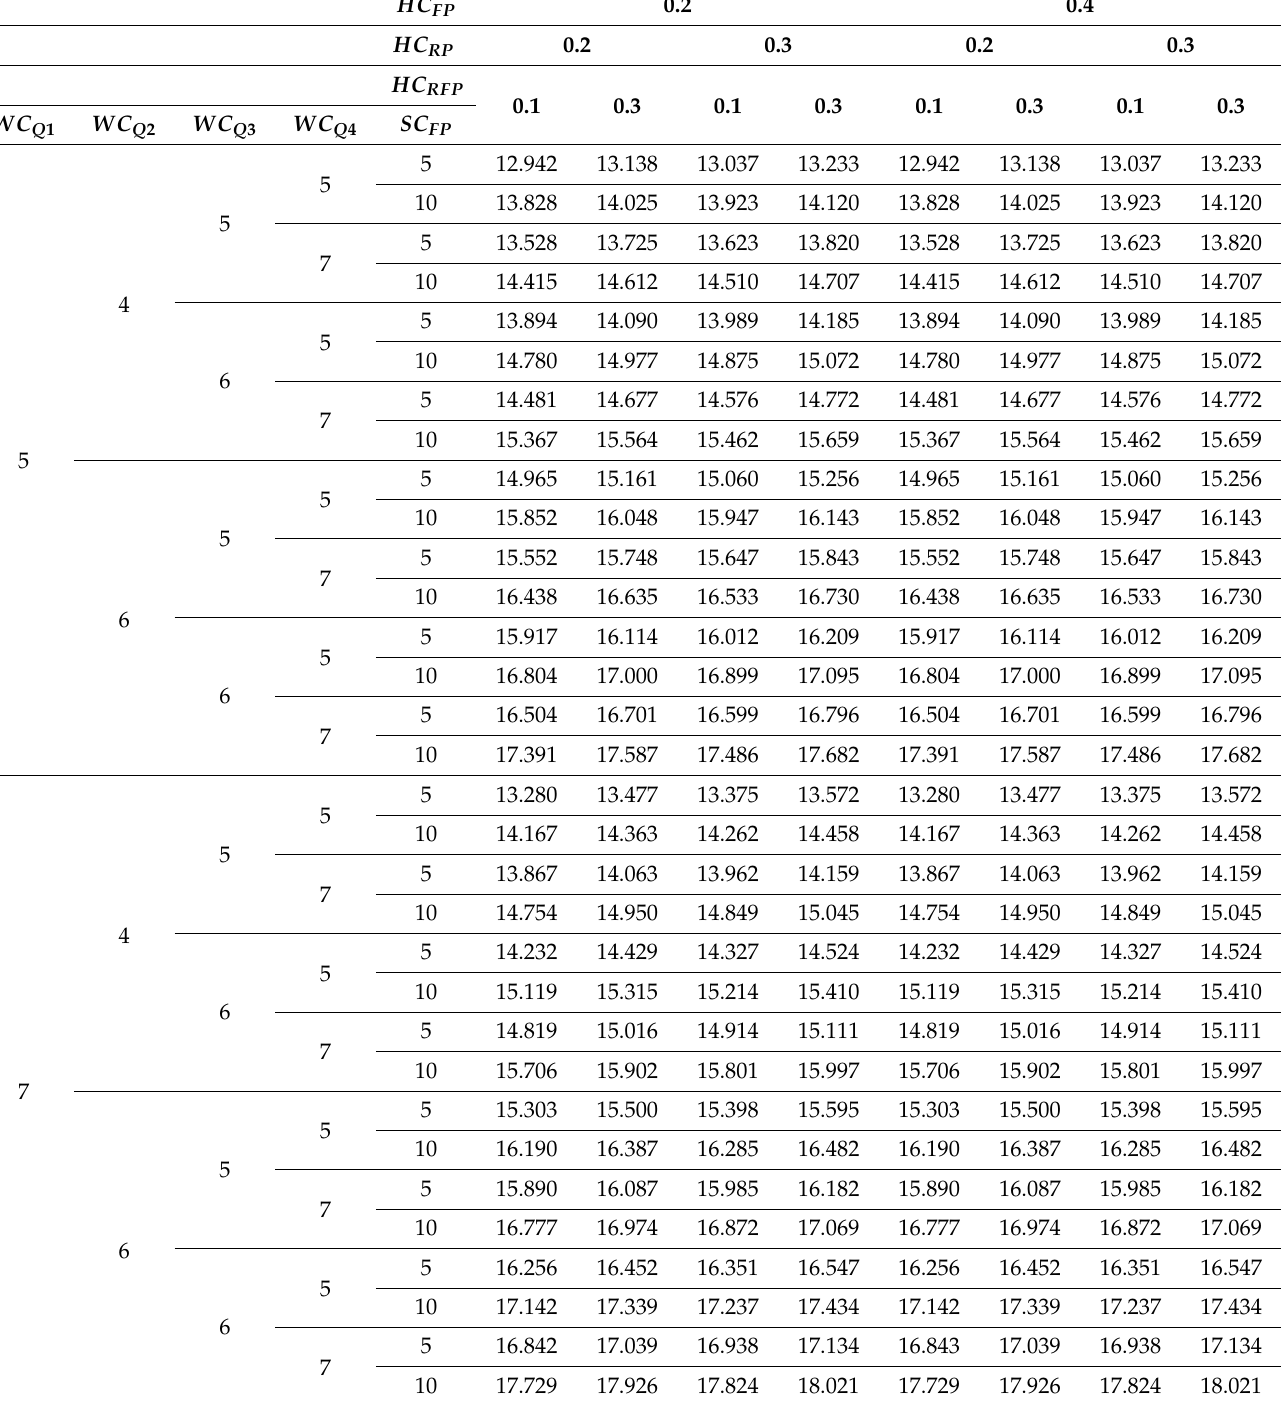
Table 4. Interpretation of cost values on E TCV